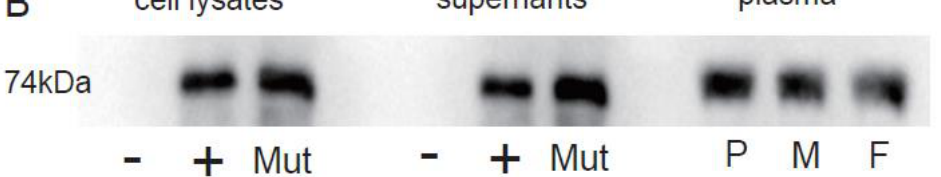
Figure 3. ( A ). FX antigen levels of the transfected cells in cell lysates and supernatants using ELISA. Data are derived from four independent measurements (SD). ( B ). Western Blot for the FX in transfected cell lysates and supernatants, as well in plasma of the proband and his parents. (-: control (empty vector); +: pcDNA3.1/FX WT; Mut: pcDNA3.1/FX Mut Thr265; P: Proband; M: Mother; F: